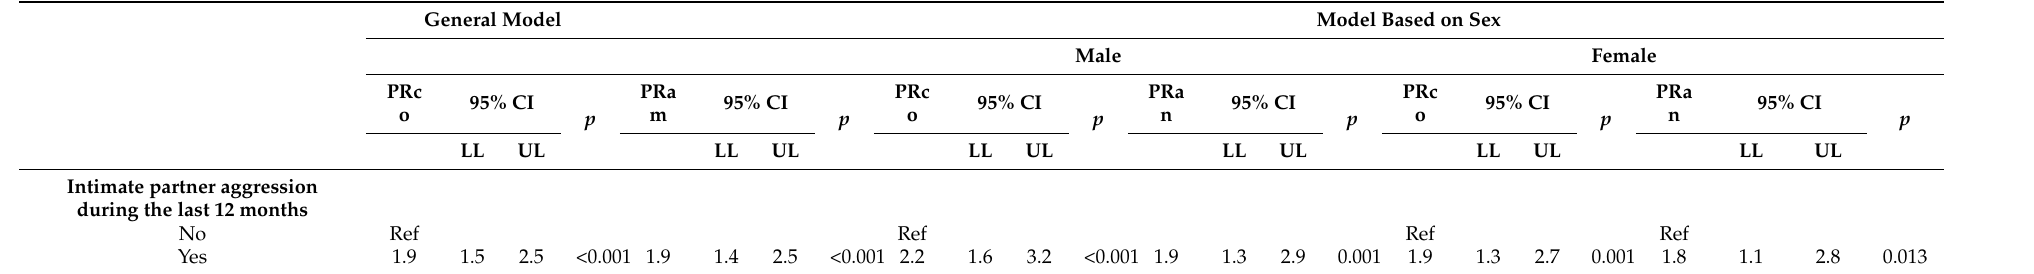
Table 4. Association between intimate partner physical aggression and excessive alcohol consumption in the population over 15 years of age in Peru 2020 ( n = 20,616). General